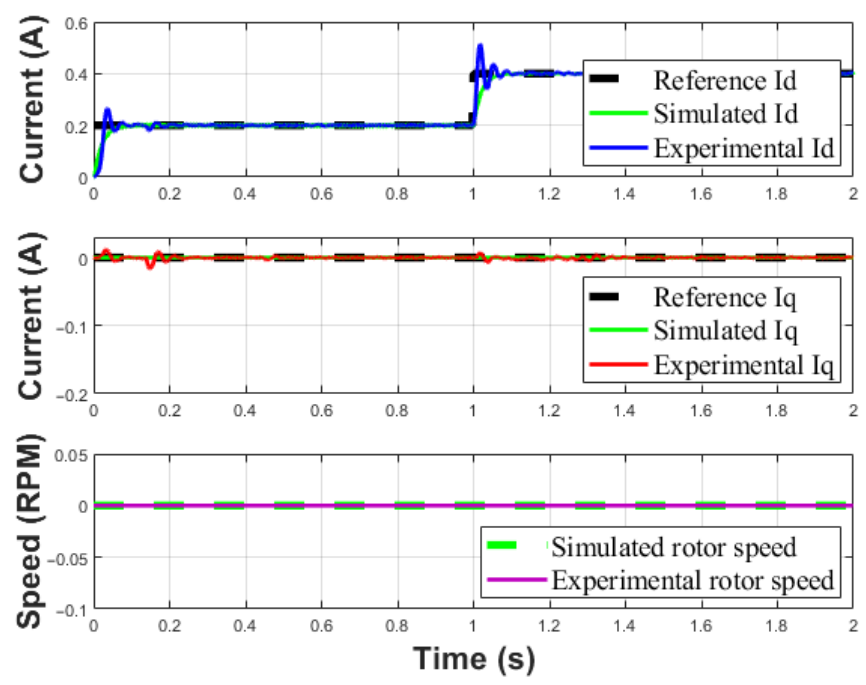
= 0.2 A and i ∗ = 0.4 A. d d